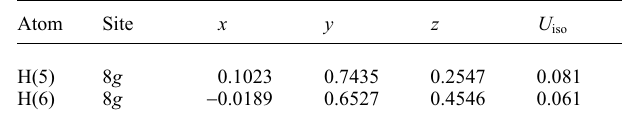
Table 2. Atomic coordinates and displacement parameters (in Å 2 ) . Table 2. continued